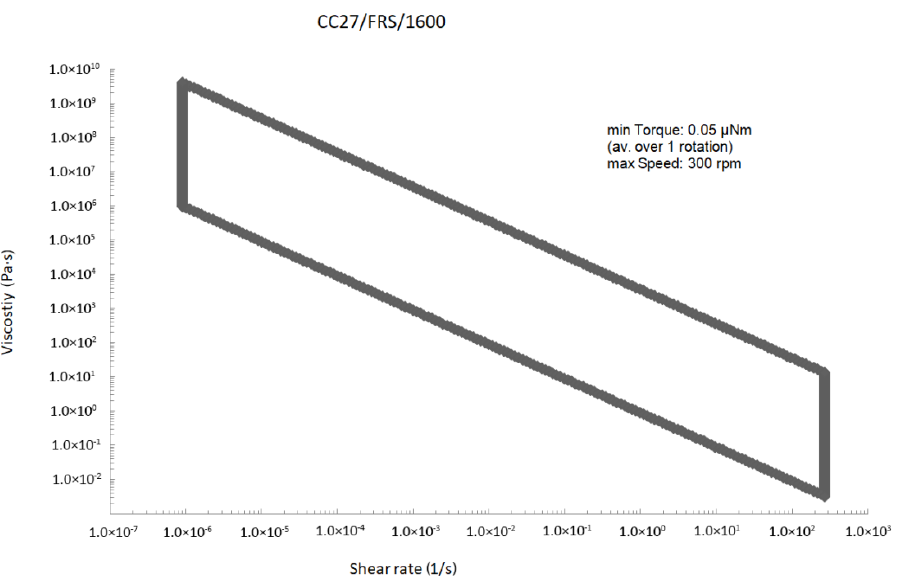
Figure 2. An envelope of the rheometer measuring range using a 26.6 mm spindle.